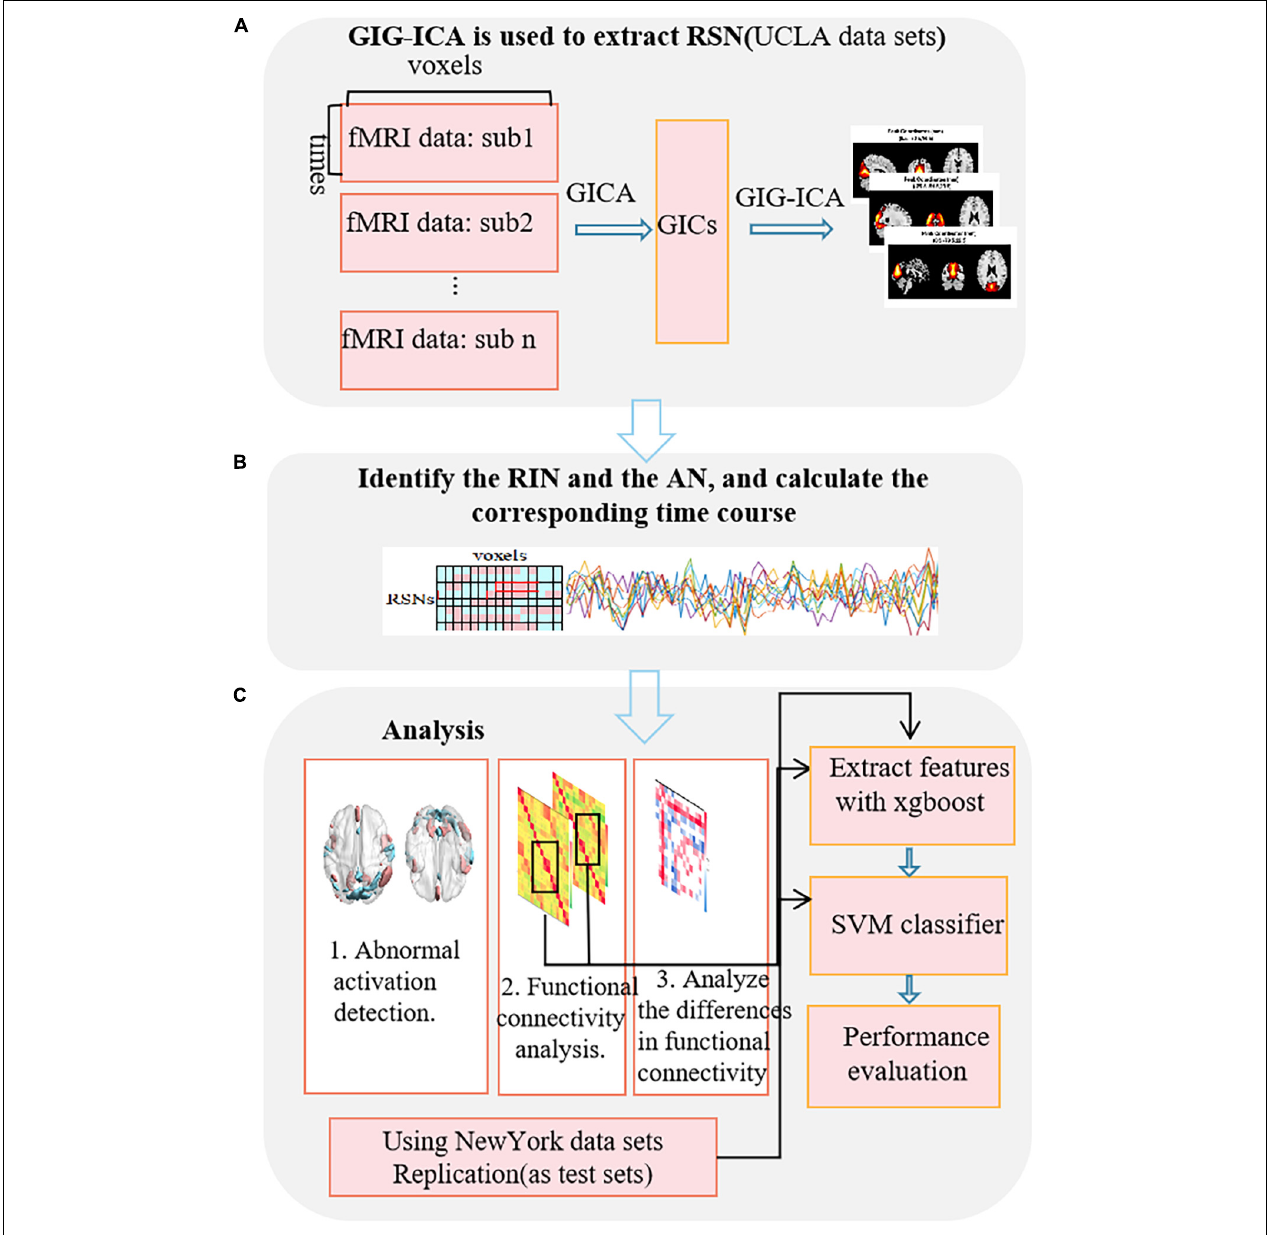
FIGURE 1 | Flowchart of the research method. (A) Extraction of the RSN using GIG-ICA. (B) Identification of the RINs and the ANs, and calculation of the corresponding time-series. (C) The analysis process based on RINs and